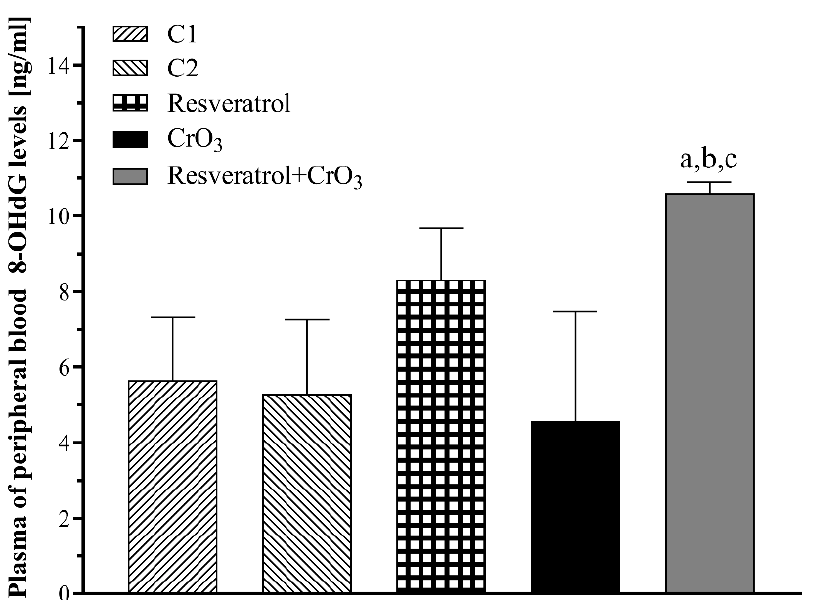
Figure 2. Effect of resveratrol and CrO 3 on 8-hydroxydeoxyguanosine (8-OHdG, 7,8-dihydro-8-ox- odeoxyguanosine) levels evaluated in peripheral blood plasma 48 h after treatments ( n = 4 mice/group). Statistical significance was determined using one-way ANOVA followed by Tukey’s post-hoc test: a p < 0.012 vs. C1; b p < 0.007 vs. C2; c p < 0.002 vs. CrO 3 . C1, Control 1, vehicle only